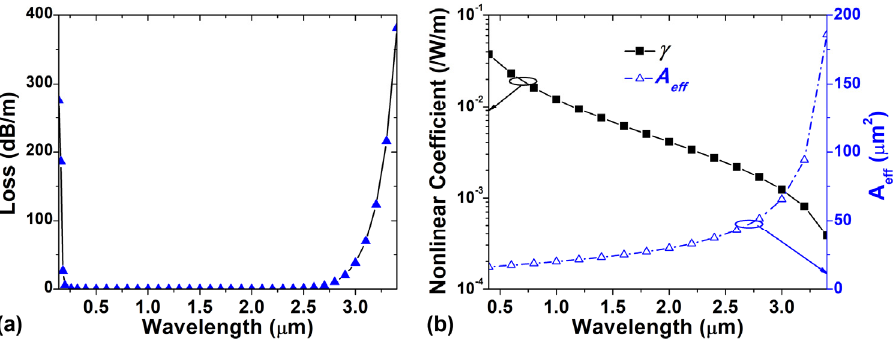
Figure 5. ( a ) Loss, ( b ) nonlinear coefficient and effective mode field area ( A eff ) of the RCF with the optimized design.